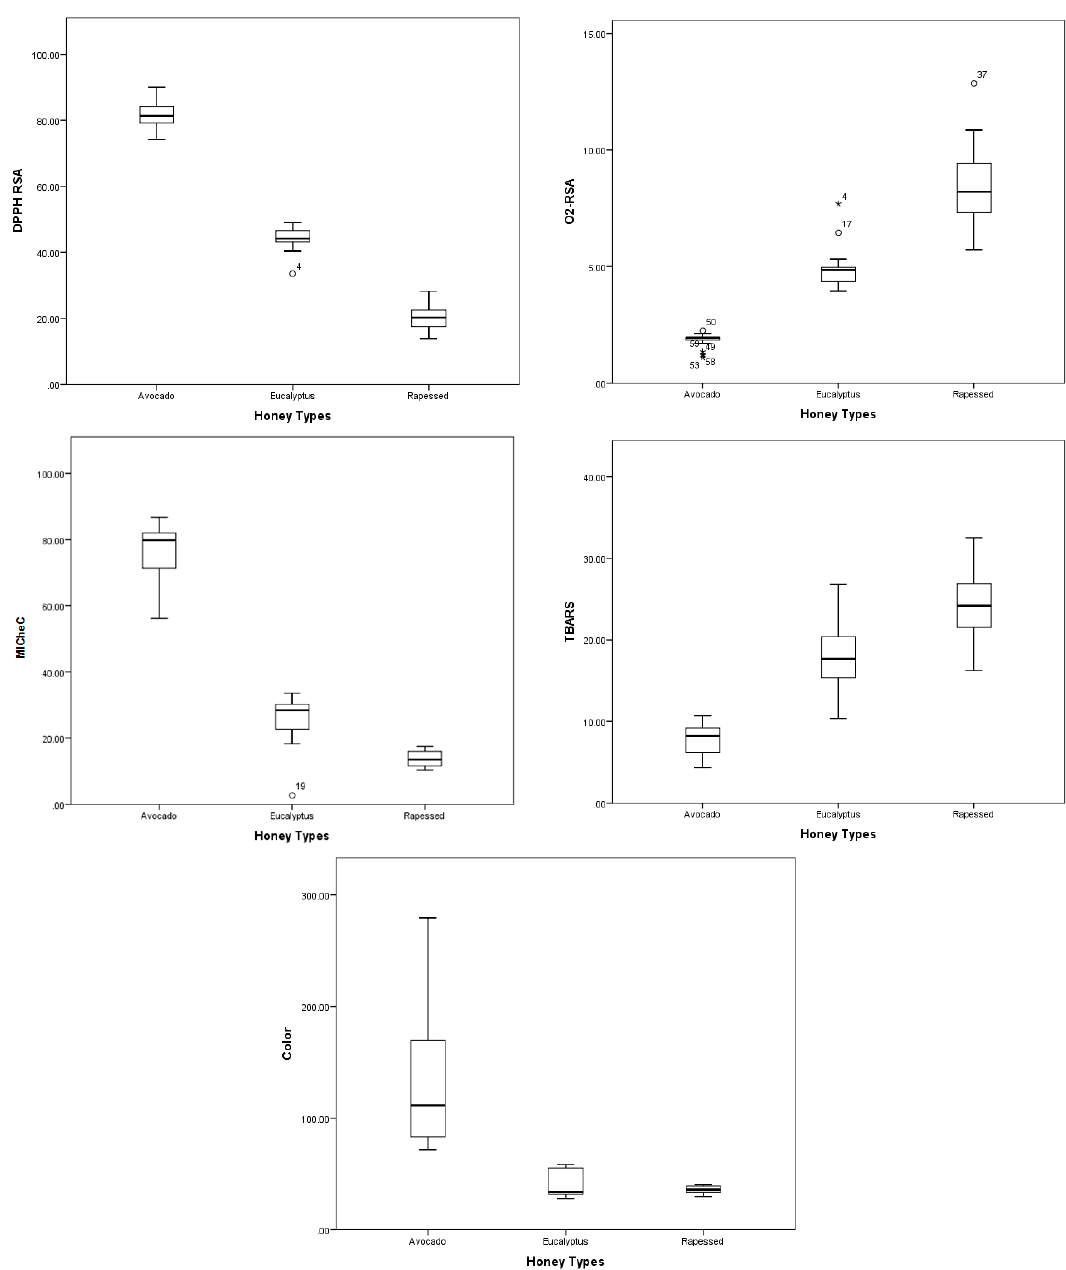
Figure 1. Box-plot diagrams of the levels of quantitative determinations in the three monofloral honeys. TPC, total phenolic content; TFC, total flavonoid content; TCC, total carotenoids content; FRAP, ferric reducing antioxidant power assay, DPPH RSA, DPPH radical scavenging activity; O 2• − RSA, superoxide anion radical scavenging activity, MICheC, metal ions chelating capacity.